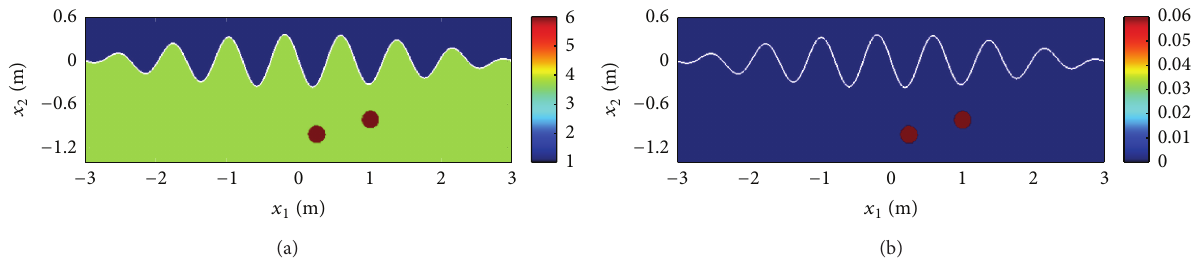
Figure 8: (a) The exact relative permittivity and (b) conductivity profiles of two circular objects and the background having a high frequency roughness.